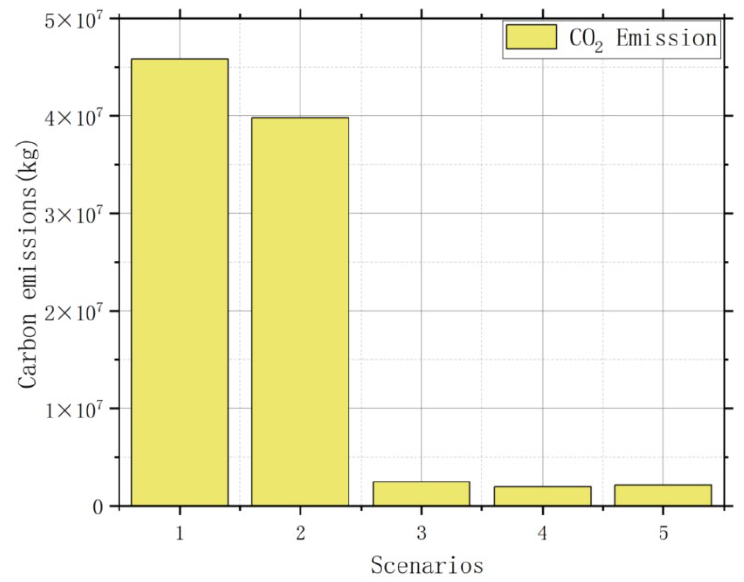
Figure 15. Carbon emissions in five scenarios